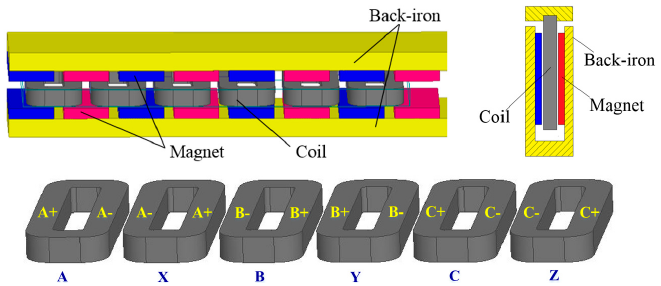
Figure 1. Permanent magnet synchronous linear motors (PMSLM) with a double secondary.